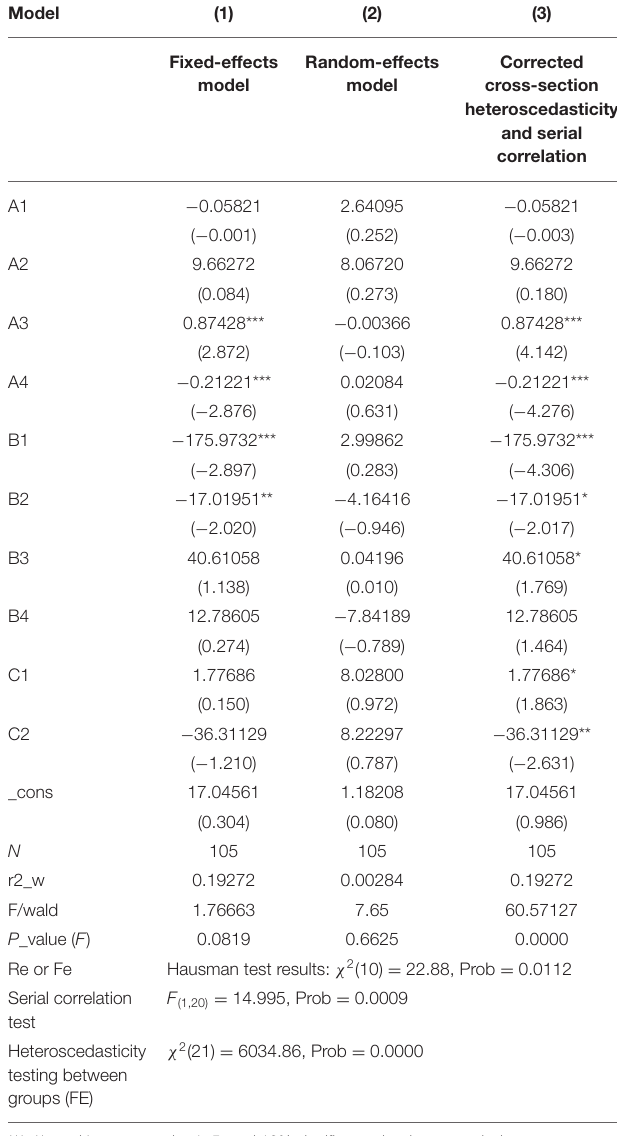
TABLE 3 | Estimation of the panel data model.